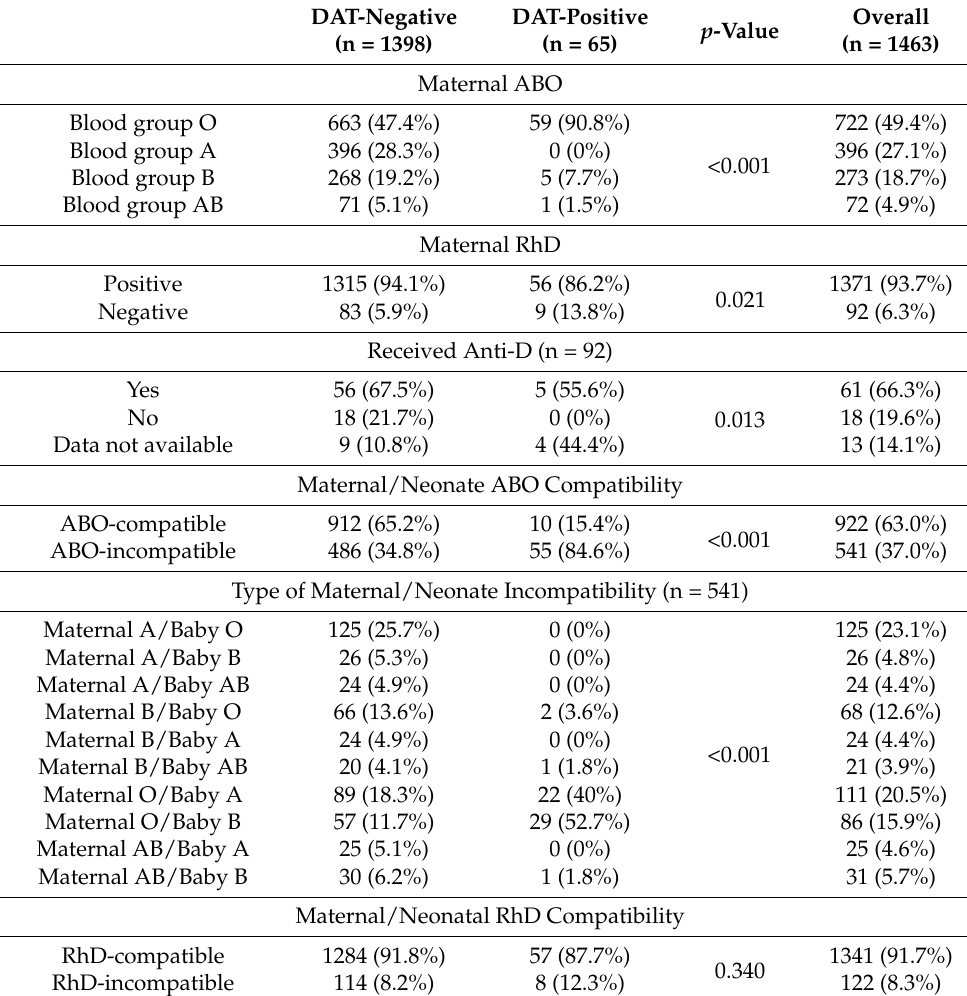
Table 2. Maternal blood groups and maternal–neonate compatibility by DAT. p -Value calculated by chi-square or Fisher exact